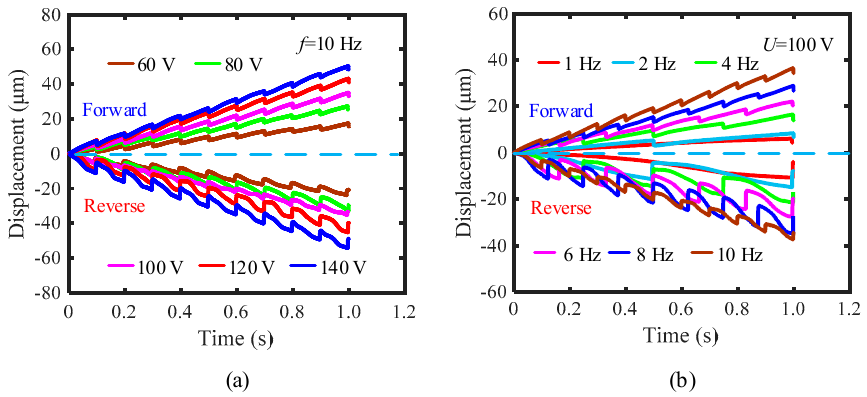
Figure 6. ( a ) Forward and reverse output displacements obtained under the fixed driving frequency of 10 Hz and various driving voltages, and ( b ) forward and reverse output displacements obtained under the fixed driving voltage of 100 V and various driving frequencies.